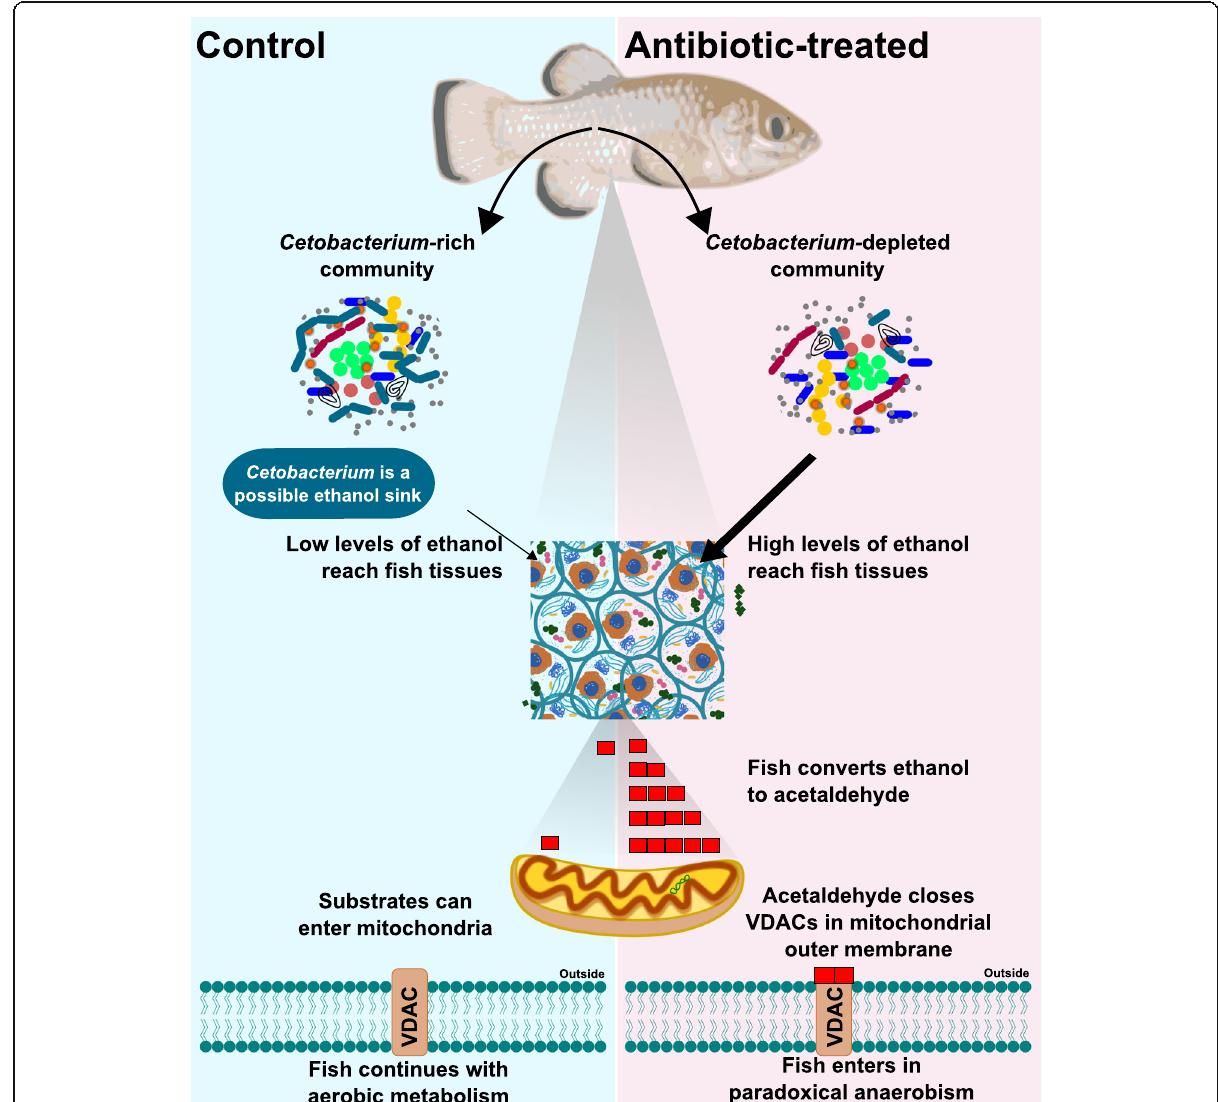
Fig. 5 Summary of the results and hypothesis. We propose that the Cetobacterium in control pupfish may be acting as an ethanol sink. Thus, depleting Cetobacterium using the antibiotic cocktail might cause increased accumulation of the acetaldehyde in fish tissues leading to closure of VDAC and eventually paradoxical